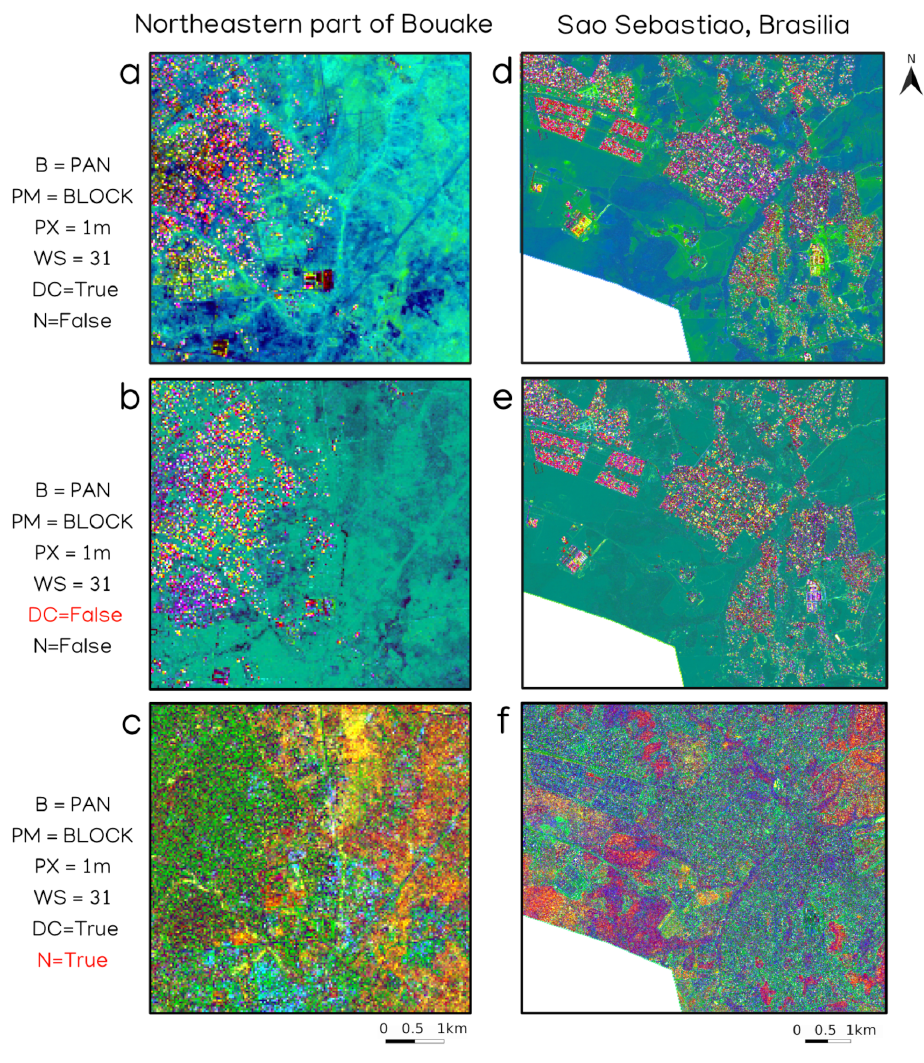
Figure 9. Influence of DC component and normalization in FOTOTEX in the characterization of urban units at the meso-scale from Pleiades images on the northeastern part of Bouake and Sao Sebastiao, Brasilia. ( a , d ) use of block method over Bouake and Brasilia, with DC component, without normalization, ( b , e ) use of block method over Bouake and Brasilia, without DC component, without normalization, ( c , f ) use of block method over Bouake and Brasilia, with DC component and normalization. The text in red highlights the modified parameter compared with image ( a ). (PX =pixel size, WS = window size, PM = partitioning method, MW = Moving Window, DC = DC component, N =